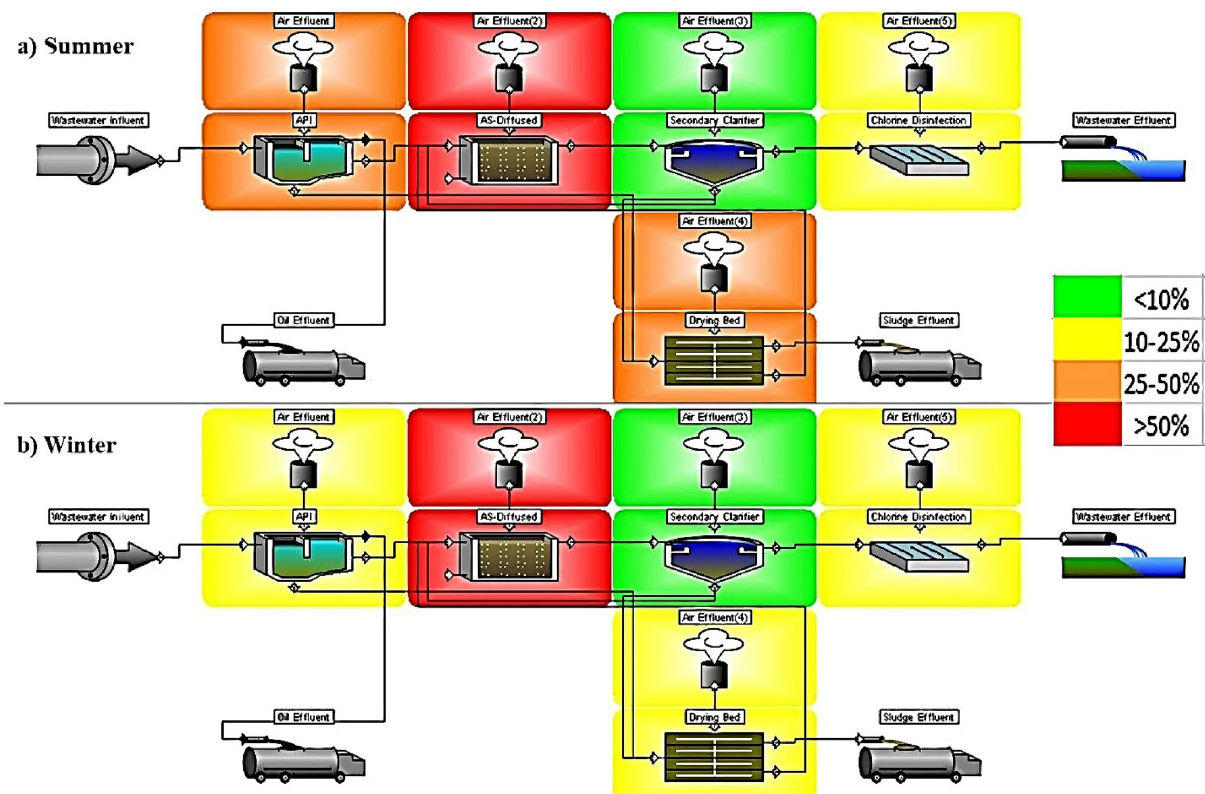
Figure 4. Emission of H 2 S to atmosphere from each unit (% of the total emission): ( a ) summer and ( b )